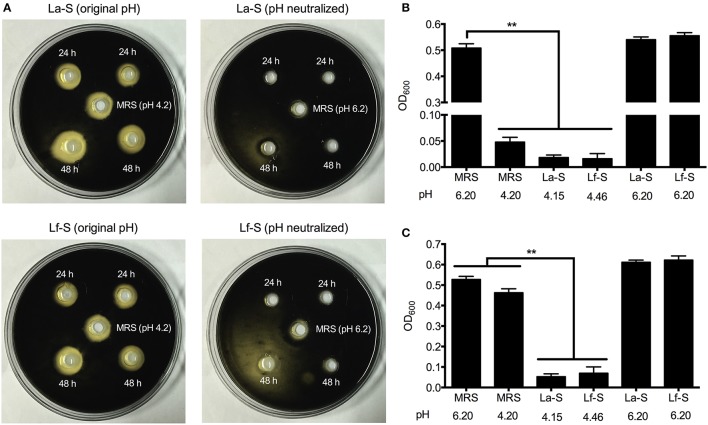
Inhibition of C. perfringens by cell-free supernatants with and without pH neutralization, obtained from L. acidophilus and L. fermentum. Agar well diffusion assay was performed and the inhibition zone was assessed visually (A). Lactobacilli supernatants were collected after 24 or 48 h of incubation. Central wells were filled with sterile MRS broth adjusted to pH 4.2 or standard MRS broth. The colonies of C. perfringens were black in the TSC agar. The growth of C. perfringens in fresh MRS broth supplemented with lactobacilli supernatants was measured by OD600 after 24 (B) and 48 (C) hours of incubation. Data are presented as mean ± standard error (n = 3). **P < 0.01. La-S, supernatants from L. acidophilus cultures; Lf-S, supernatants from L. fermentum cultures; MRS, Mann-Rogosa-Sharpe medium.